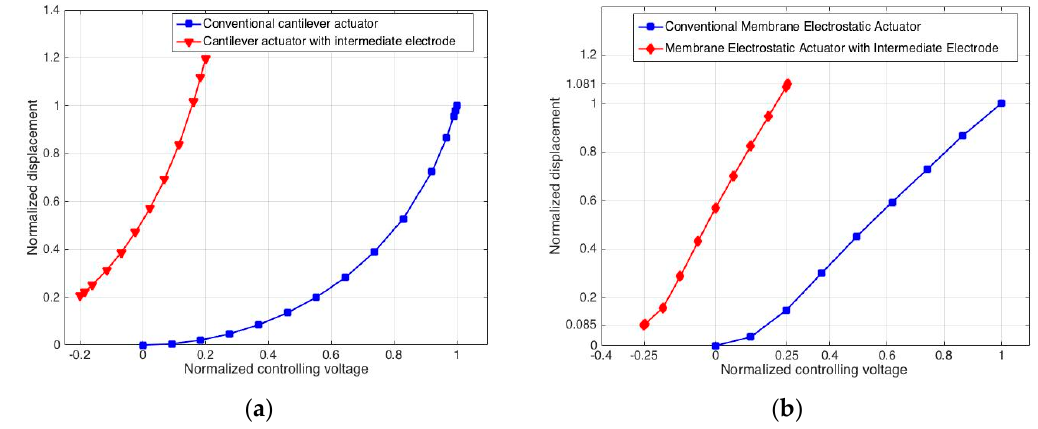
Figure 4. Simulations showing the tri-electrode topology achieving similar stroke as convention electrostatic actuators. ( a ) Cantilever simulation showing V i needing to be only − 0.2 V pull-in < V i < 0.2 V pull-in ; ( b ) Membrane simulation showing V i needing to be only − 0.25 V pull-in < V i < 0.25 V pull-in